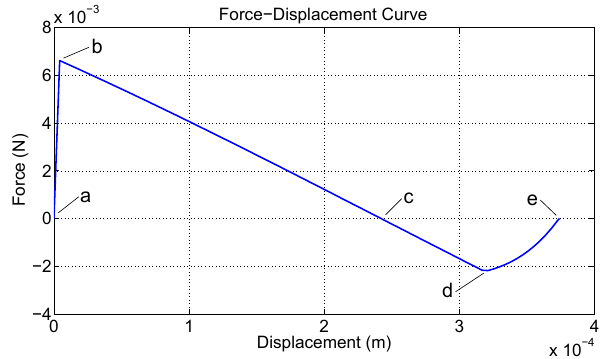
Figure 3. Force vs. displacement curve for a single flexural beam angled at 14 ◦ . (a) First stable position (fabricated position). (b) Switching force from position 1 to position 2. (c) Unstable equi- librium point. (d) Switching force from position 2 to position 1. (e) Second stable